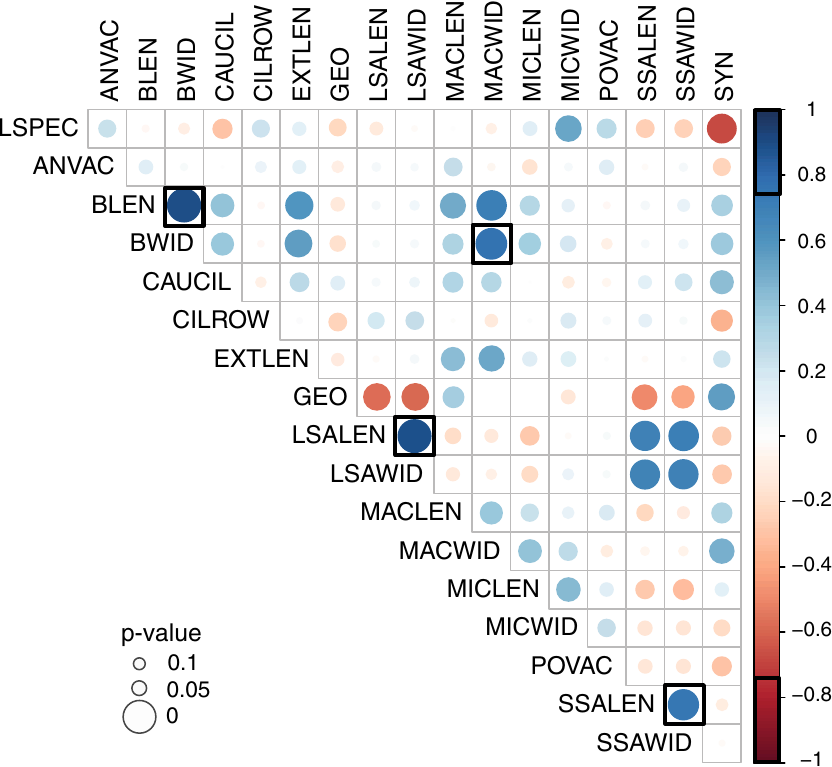
Figure 7. Pearson-correlations of morphometric, symbiont and syngen data of Paramecium strains under study. Colored dots indicate the strength of correlation, and the size of dots represent p-values. Bold squares highlight significant correlations, with − 0.75 > r > 0.75 and p < 0.05. Abbreviations: ANVAC number of excretory pores in anterior contractile vacuole, ALSPEC algal species, BLEN body/cell length, BWID body/cell width, CAUCIL caudal cilia length, CILROW number of ciliary rows, EXTLEN extrusome/trichocyst length, GEO geographical region, LSALEN large symbiotic algae length, LSAWID large symbiotic algae width, MACLEN macronucleus length, MACWID macronucleus width, MICLEN micronucleus length, MICWID micronucleus width, POVAC number of excretory pores in posterior contractile vacuole, SSALEN small symbiotic algae length, SSAWID small symbiotic algae width, SYN syngen